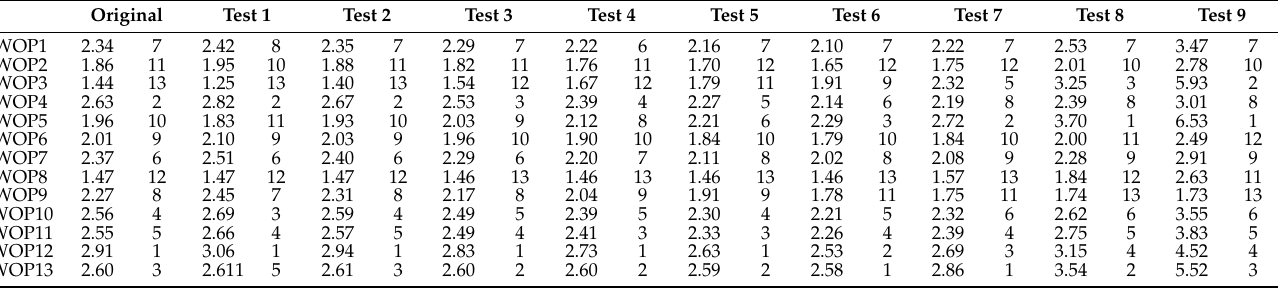
Table A2. Warehouse performance weight and ranks for sensitivity analysis in various